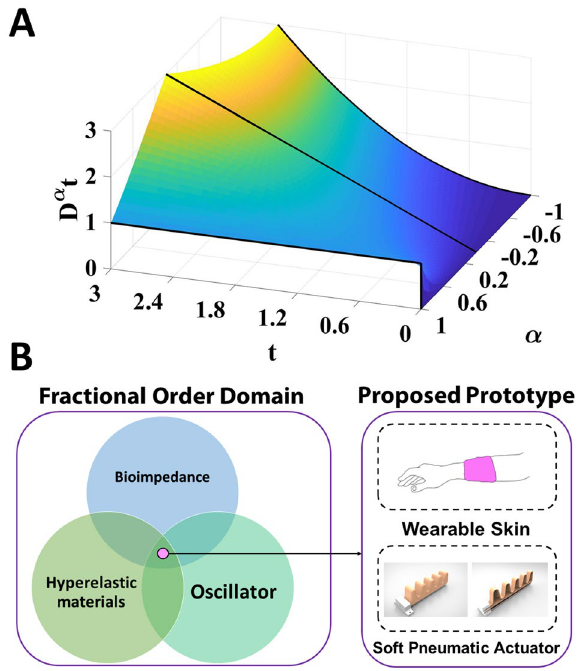
Figure 1. Fractional order domain and the proposed prototype. ( A ) The integral of step function throughout different fractional orders. ( B ) The proposed work is based on three main pillars; Biological impedance of tissues, hyper elastic materials and oscillators. These pillars are common for their realization in the context of the fractional order domain, and upon them our proposed prototype is based. Adding channels beneath a soft E-skin or embedded inside a soft pneumatic actuator which are filled by biological soft tissues can augment tactile sensing capability based on changes of the tissues